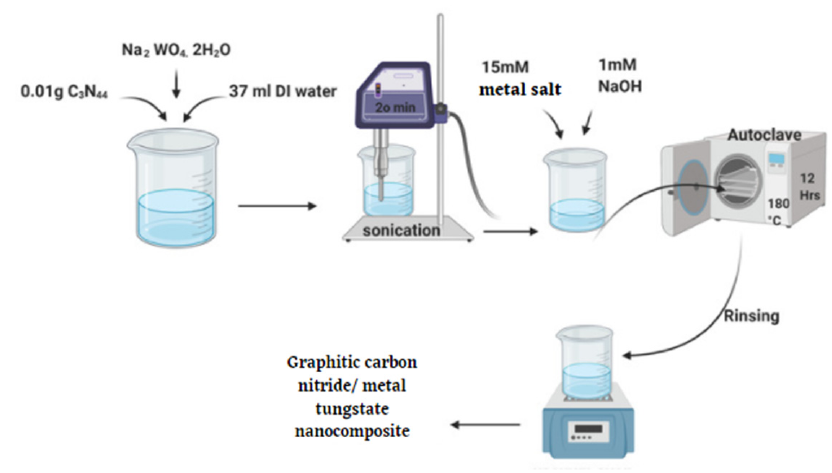
Figure 2. Schematic synthesis of graphitic carbon nitride-fabricated metal tungstate nanocompo- site.